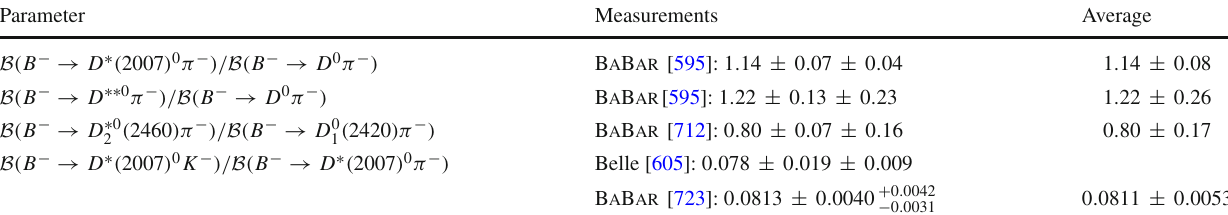
Table 143 Relative decay rates to excited D mesons Parameter